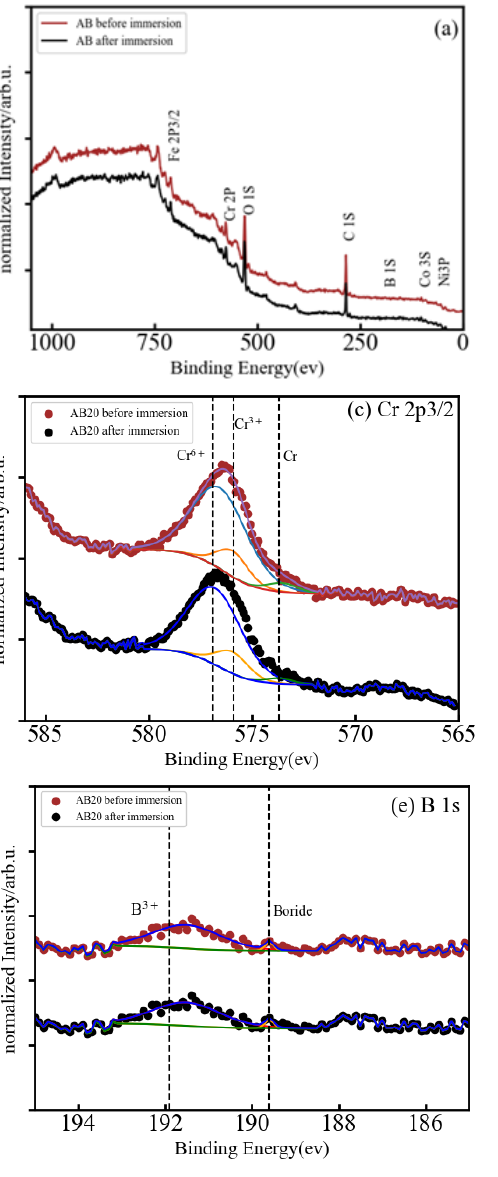
Figure 5. ( a ) Normalized XPS spectrum of AB20 after immersion in 3 wt.% NaCl, and ( b – e ) high- resolution XPS spectra of Fe 2p3/2, Cr 2p3/2, O 1s, and B 1s.